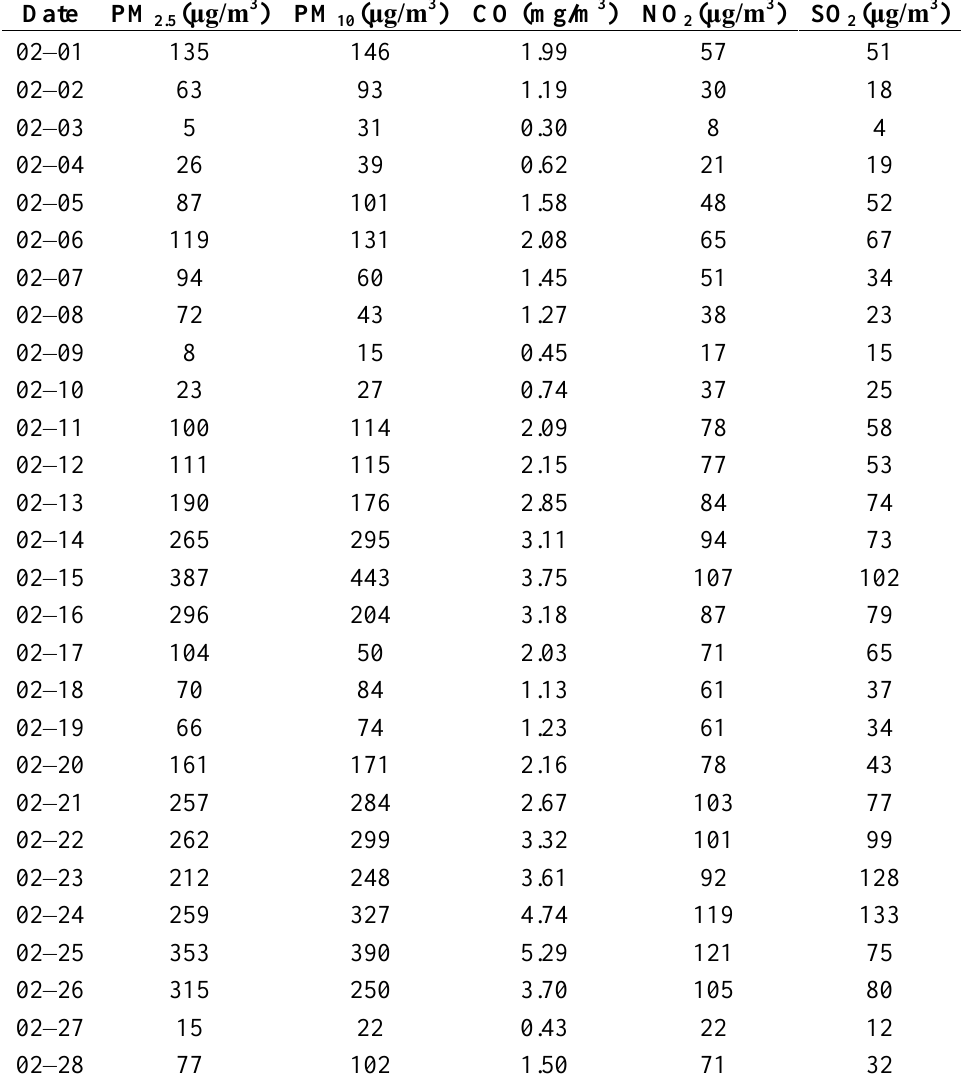
Table 3. Air quality data of Beijing city in February 2014.